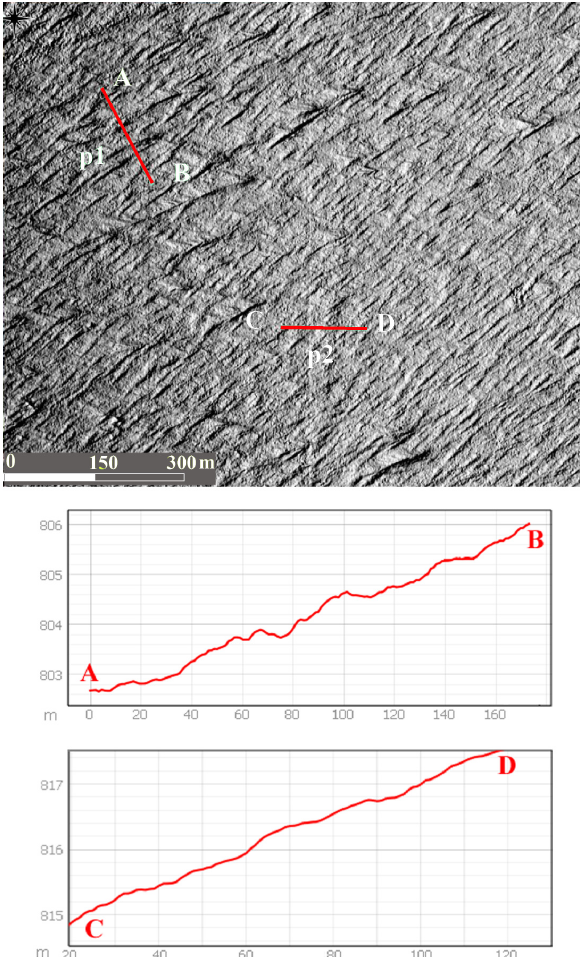
Figure 4. Microtopographic snow/ice features of eolian origin at the site 1: the 1-m gridded hill-shaded map and two cross- sections A–B and C–D. One can see snow/ice microfeatures of eolian origin. For the site location, see Fig. 1 Figure 3. The area of the initial section of the sledge route from the Progress to Vostok Stations (the mid-January survey): the 1- m gridded hill-shaded elevation model For geomorphometric calculation, 3D modeling, and visualization, we utilize the following software: LandLord 4.0